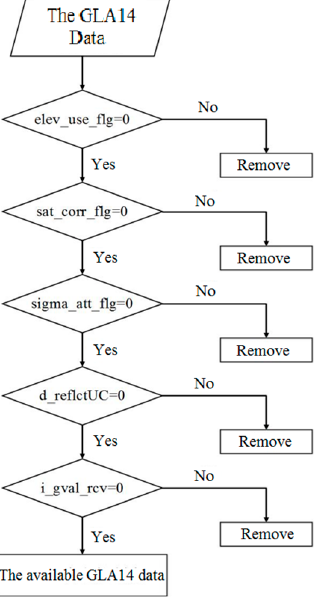
Figure 6. Workflow of multi-criteria constraint on Ice, Cloud, and Land Elevation Satellite’s Geoscience Laser Altimeter System data.